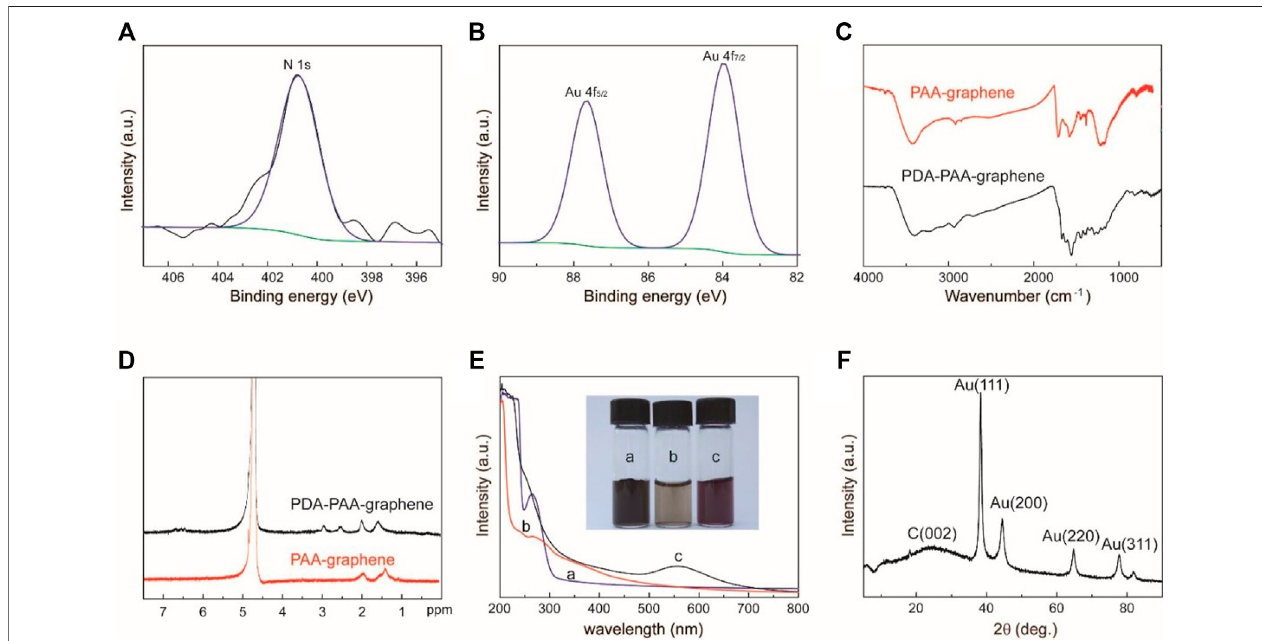
FIGURE 2 | (A) The N1s XPS spectra of Au NPs-PDA-PAA-graphene (B) The Au4f XPS spectra of Au NPs-PDA-PAA-graphene (C) FT-IR spectra for PAA- graphene and PDA-PAA-graphene) (D) 1H NMR spectrum of PDA-PAA-graphene and PAA-graphene in D 2 O (E) UV-vis absorption spectra and photographs (inset) of PAA-graphene (A) , PDA-PAA-graphene (B) and Au NPs-PDA-PAA-graphene (C) solutions (F) XRD pattern of Au NPs-PDA-PAA-graphene composite.